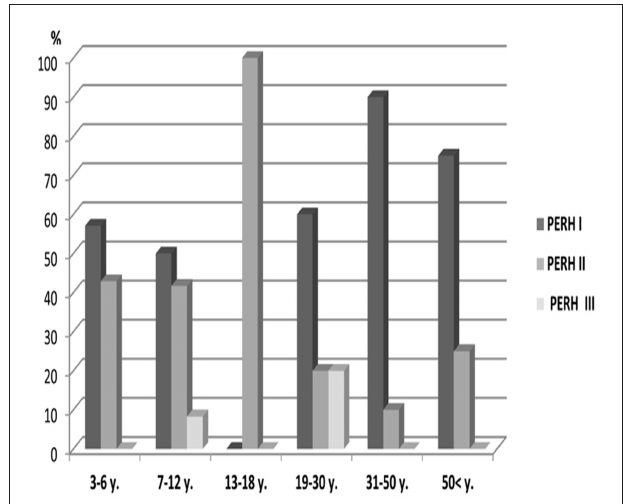
FIGURE 4 | Frequency distribution (%) of female patients by pathological EEG responses to hyperventilation (PERH) types for various age groups in Group B. A majority of female patients developed PERH-I followed with PERH-II ( p < 0.05) irrespective of age.